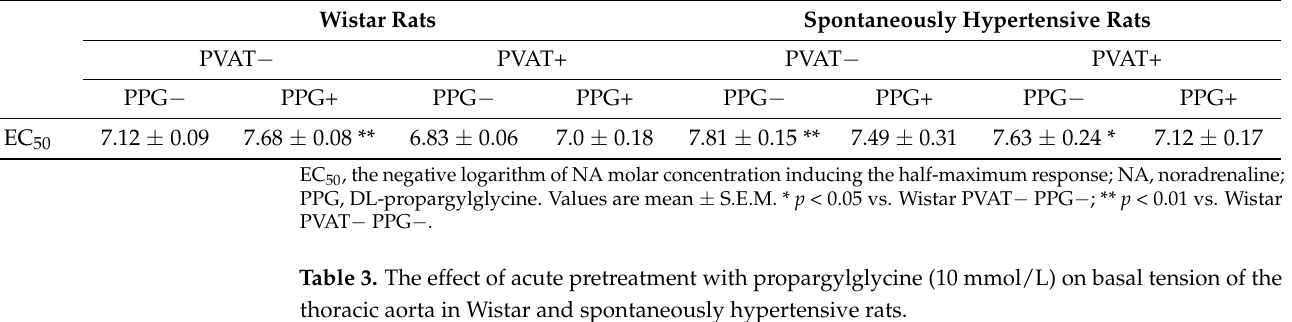
Table 3. The effect of acute pretreatment with propargylglycine (10 mmol/L) on basal tension of the thoracic aorta in Wistar and spontaneously hypertensive rats. Wistar Rats Spontaneously Hypertensive Rats PVAT − PVAT+ PVAT − PVAT+ DL-propargylglycine (g) 0 ± 0.00 − 0.08 ± 0.02 0.14 ± 0.06 * − 0.02 ± 0.03 PVAT, perivascular adipose tissue. Positive values = increase in basal tension; negative values = decrease in basal tension. * p < 0.05 vs. Wistar PVAT −